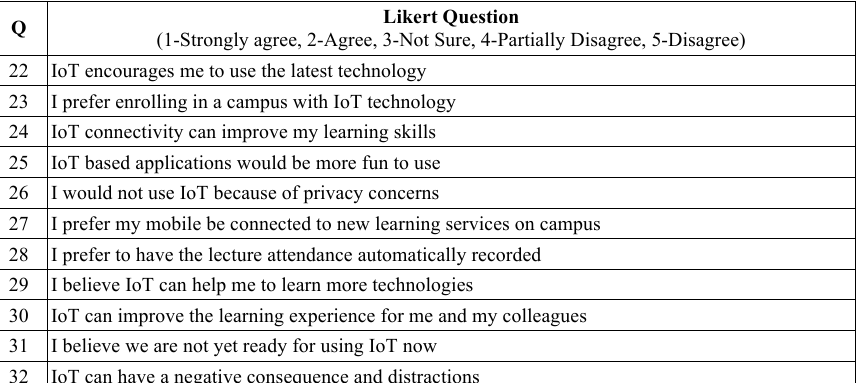
Table 1. Sample Experiment Questions in the Likert